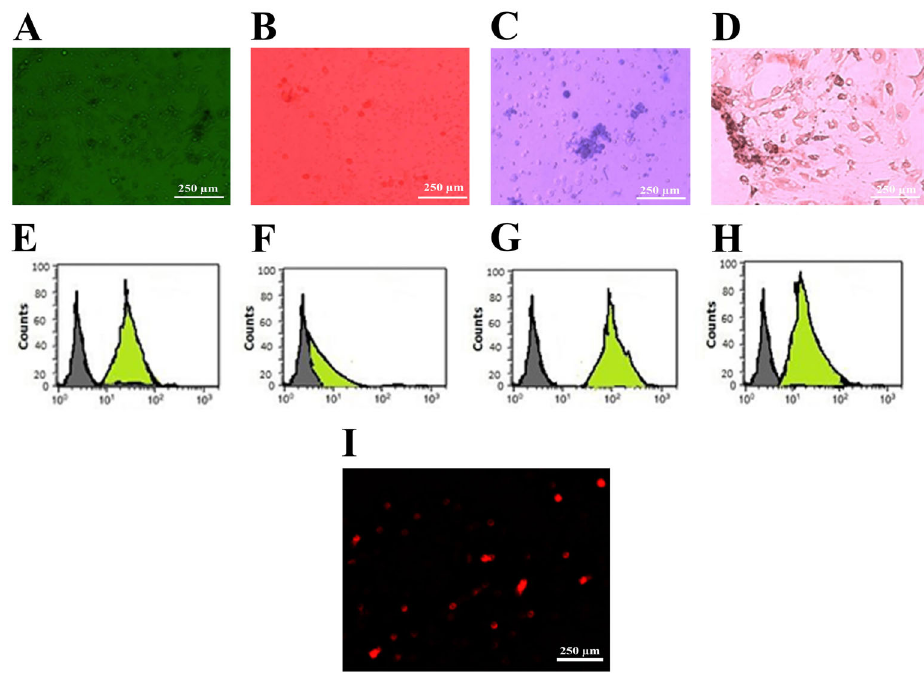
Figure 1. Characterization and homing of bone marrow smooth muscle cells (BM-MSCs) in aortic tissue of rats experimentally induced with atherosclerosis. Morphological and histological staining of differentiated BM-MSCs into undifferentiated MSCs ( A ), and MSCs differentiated into osteoblasts stained with Alizarin red stain ( B ), chondrocytes stained with Alcian blue stain, and ( C ), adipocytes stained with oil red stain ( D ). Flow cytometry charts for cells CD29 + ve ( E ), CD34-ve ( F ), CD90 + ve ( G ), and CD105 + ve ( H ). I , Photomicrograph of a section of aorta from atherosclerotic group treated with stem cells showing positive immuno fl uorescent. Scale bar 250 m m.